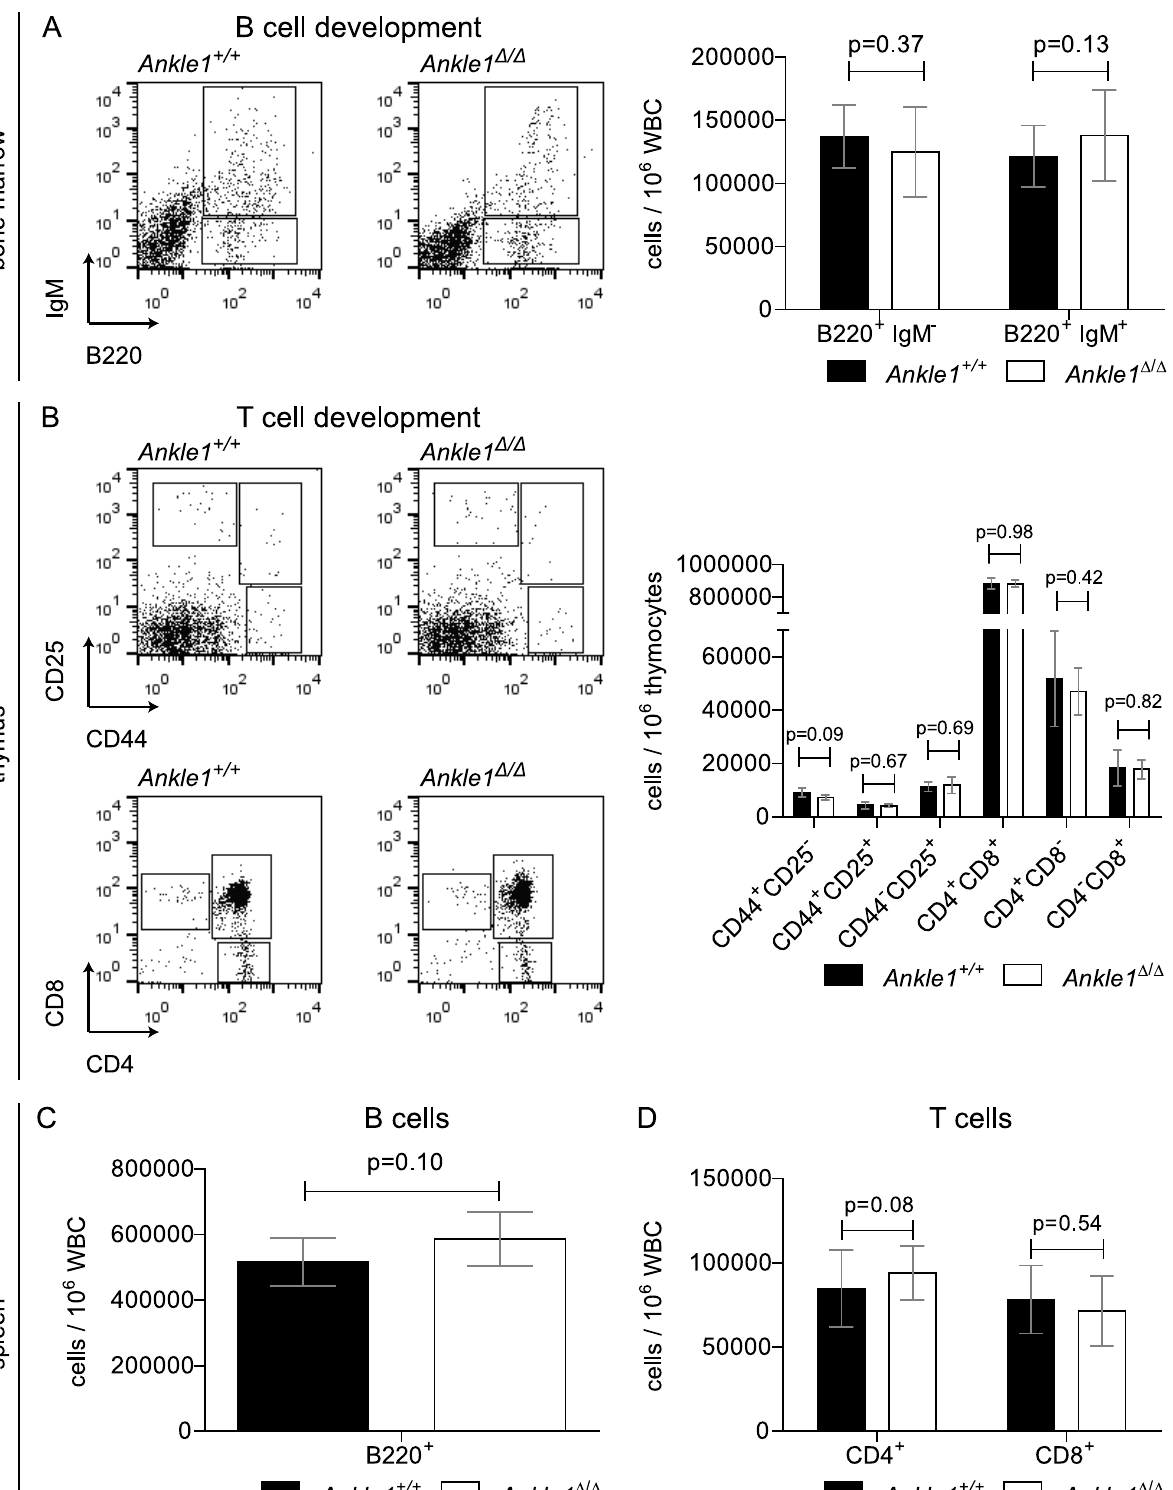
Fig 4. Flow cytometric analysis of lymphoid differentiation in 8 weeks old Ankle1 Δ / Δ mice. (A) Representative dot plots of B cell progenitors (B220 + IgM - ) and B cells (B220 + IgM + ) in white blood cells (WBC) from bone marrow of an Ankle1 +/+ and an Ankle1 Δ / Δ mouse and relative quantification of the B220 + IgM - and B220 + IgM + cells in a bar graph; (B) Representative dot plots of consecutive developmental stages of T cell progenitors in thymus of an Ankle1 +/+